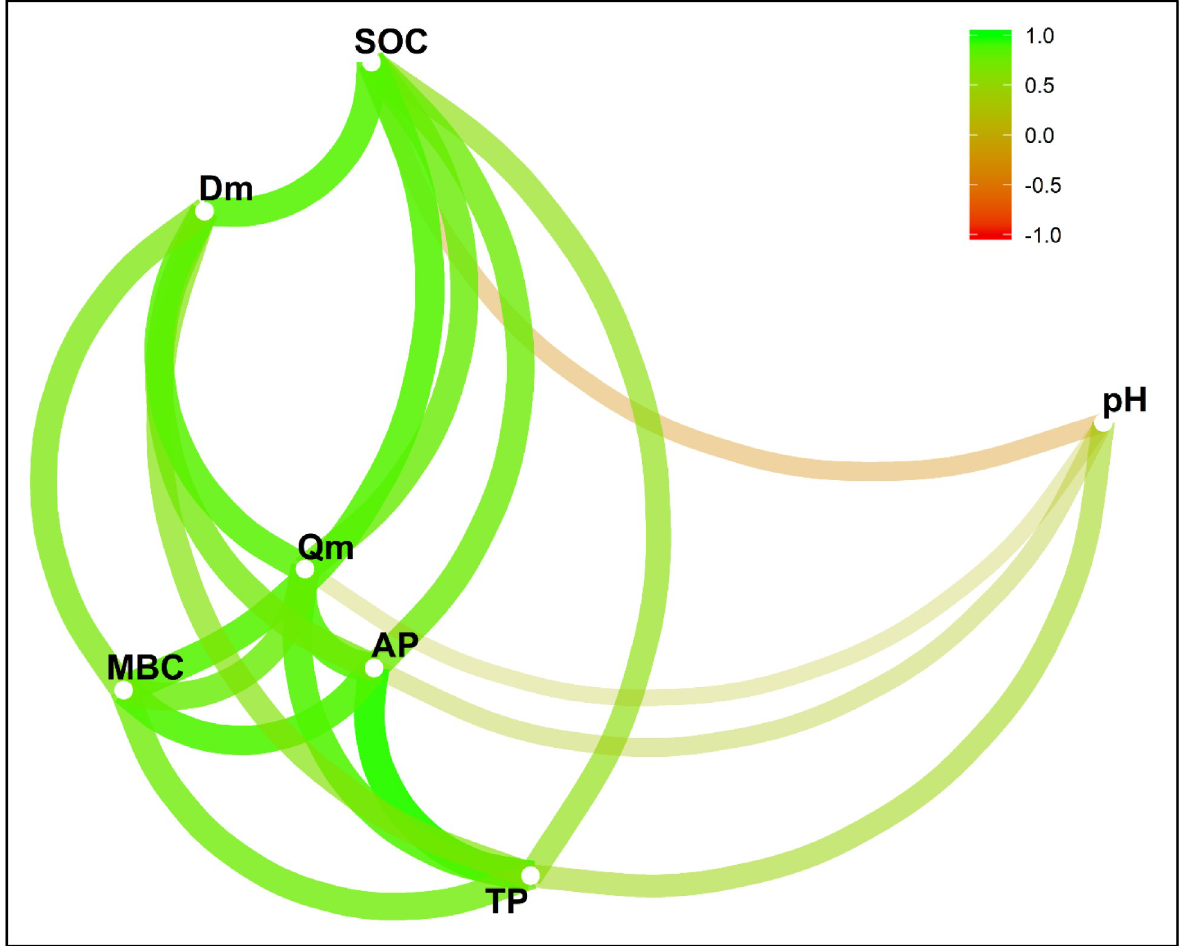
Fig 4. A proposed conceptual framework showing the linkage among soil pH, SOC, total P (TP), available P (AP), Q m , D m and the MBC. The linkage is based on the relationships between different variables. The color of each line refers to the degree of relationship between the variables. The variations in the changes in Q m and D m were mainly due to SOC, TP and AP. SOC played a dominant role among these factors. Consequently, adsorption and desorption were affected by the SOC content in the